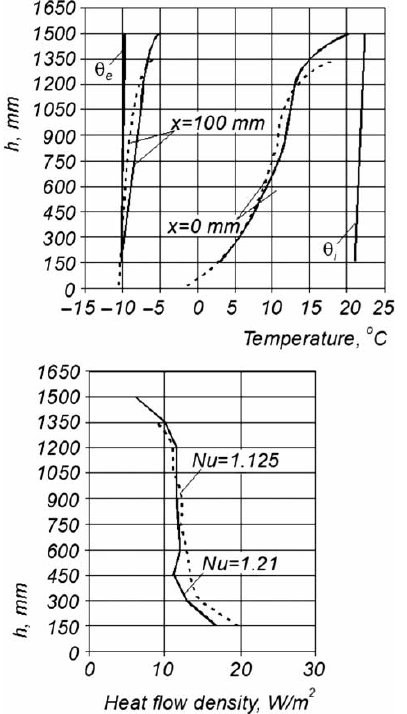
Fig. 9. Temperature curves and heat flow density values in the ventilated construction considering sample MV-4 in cases of natural and forced convection ( grad P (cid:2) 3.0 Pa/m) when u i (cid:2)(cid:4) 20 8 C, u e (cid:2) (cid:5) 10 8 C. The external thermal- insulating layer is non-wind-protected. Straight lines mark the values of the Nusselt criterion when heat transfer is affected only by natural convection; dotted lines mark the effect of both natural and forced convection ( grad P (cid:2) 3.0 Pa)